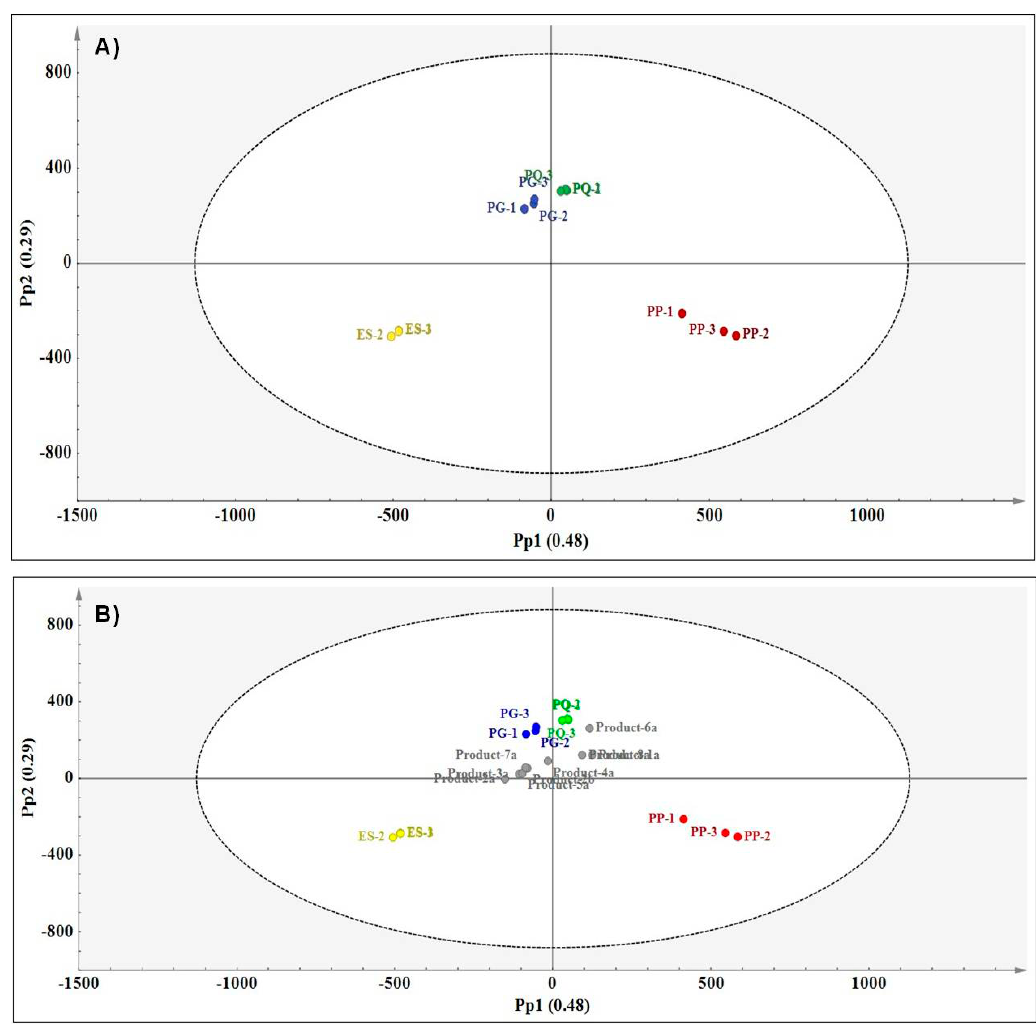
Figure 7. ( A ) OPLS-DA score plot (Pp1 vs. Pp2) showing species separation (PG— P. ginseng (blue); PG— P. quinquefolius (green); PP— P. pseudoginseng (red) and ES— E. senticosus (yellow) and ( B ) prediction plot (Pp2 vs. Pp2) showing the relationships between the reference materials and the commercial products based on LC-MS data. Table 4. Putative biomarkers (retention time/mass pairs) and tentative identification of compounds responsible for the chemical differences between the observed clusters based on UHPLC-MS data. Retention Time (min) m / z Ratio Tentative Identification E. senticosus Cluster